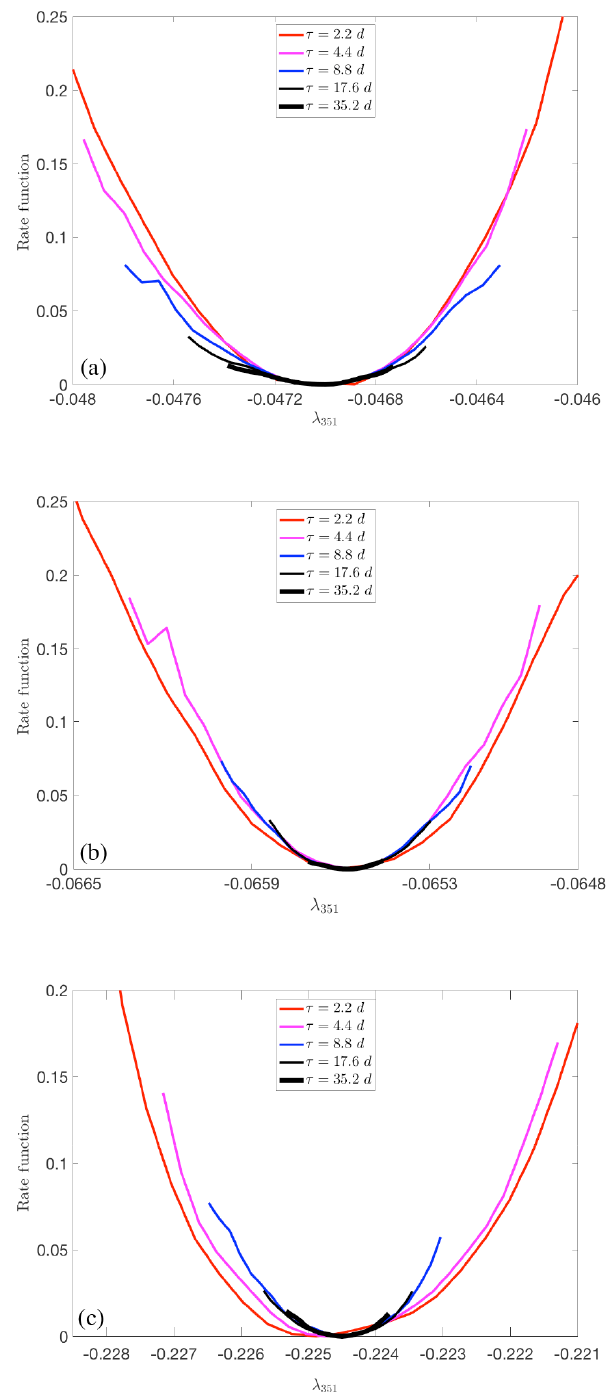
Figure 20. Estimate of the rate function describing the large devia- tion law of the 351st FTLE for MAOOAM with no dissipation (a) , reference value for the dissipation (b) , and enhanced dissipation by a factor of 10 (c)